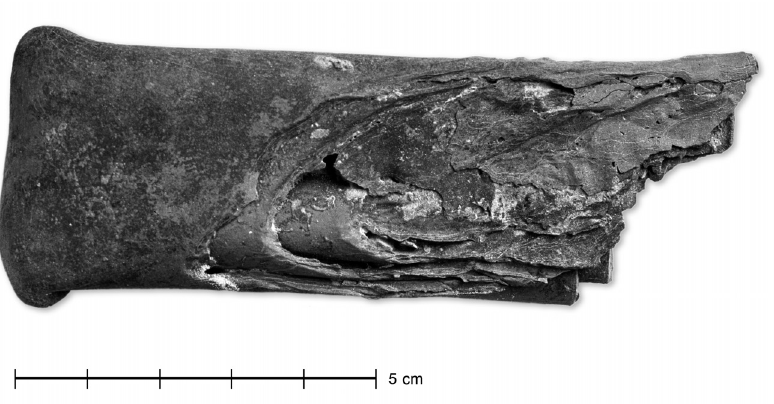
Figure 5: Image of DTM 2 (Blänsdorf 2012: CD